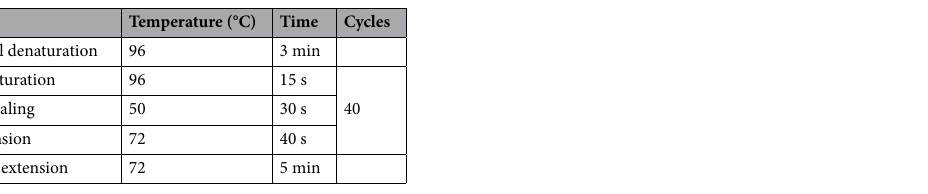
Table 3. PCR protocol used for amplification of foraminiferal COI